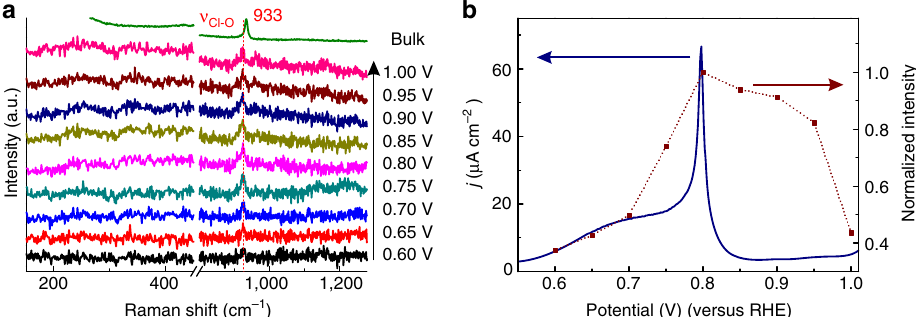
Figure 2 | Raman spectra of the hydroxyl phase on Pt(111). ( a ) Potential dependent Raman spectra and ( b ) the Raman intensity of the band at 922cm (cid:2) 1 compared with the electrochemical current as obtained by scanning with 50mVs (cid:2) 1 on a Pt(111) electrode in 0.1M HClO 4 electrolyte. The blue line in b is the voltammetric current and the squares correspond to the Raman intensities estimated from a . The Raman spectra shown in a were collected during 55s.